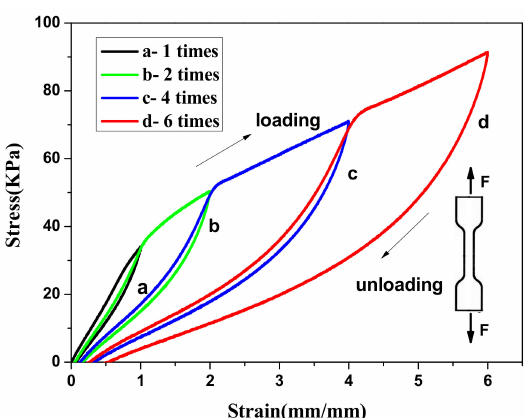
Figure 8. Stress–strain curves during loading-unloading cycles at di ff erent critical compression strains of the Agar / PAA / HEC